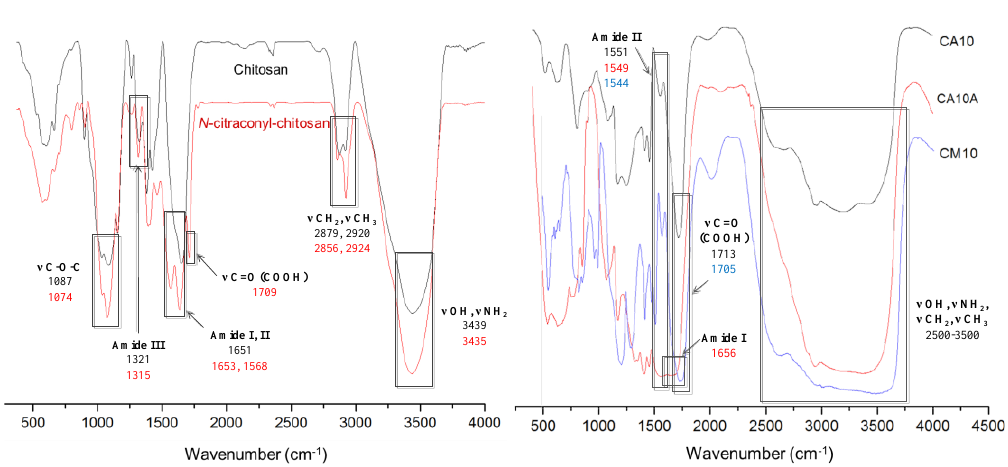
Figure 3. FTIR spectra for chitosan, N -citraconyl-chitosan (left), and selected hydrogels (right). Chitosanexhibits specificabsorptionbands inthe FTIRspectrum, as follows: oneintense